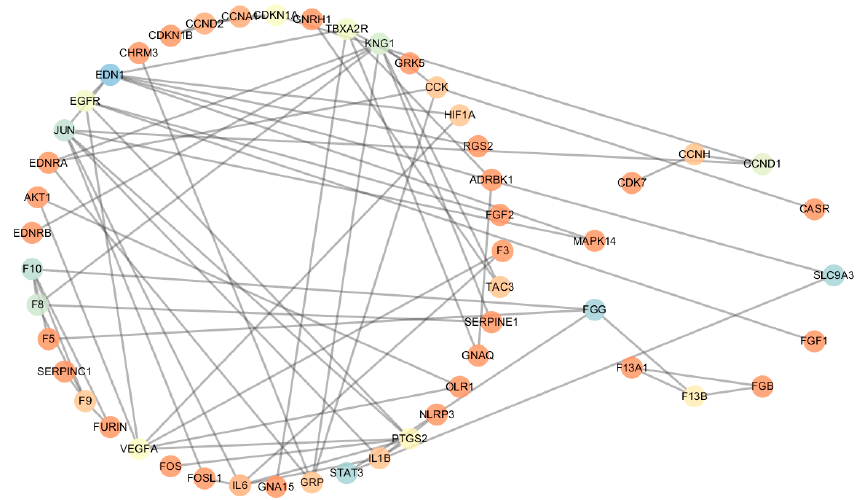
Figure 3. CHD CePIN colored based on the betweenness of each node. Red (least) → light red → yellow → light blue → blue (greatest). Shared nodes are on the left, and unique nodes are on the right. Table 3. Nodes with the highest degree and betweenness values in CHD CePIN.